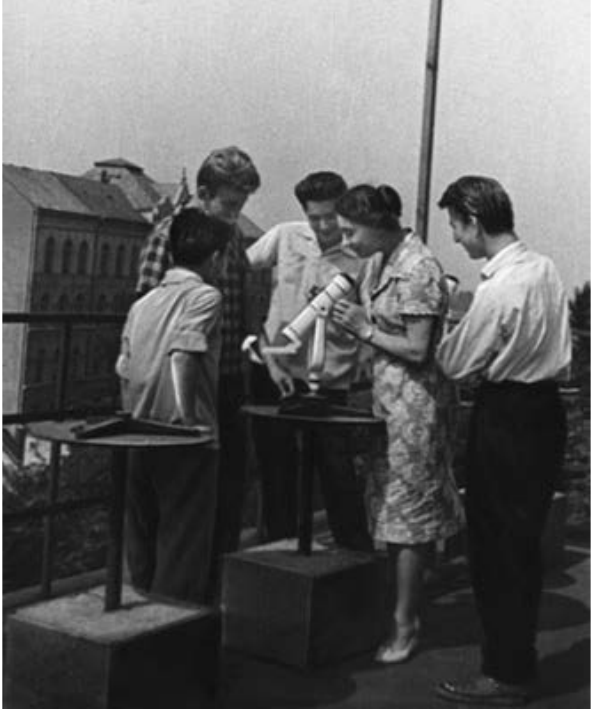
Figure 1. Uzhgorod station in Ukraine. Directress M.V. Bratijchuk surrounded by